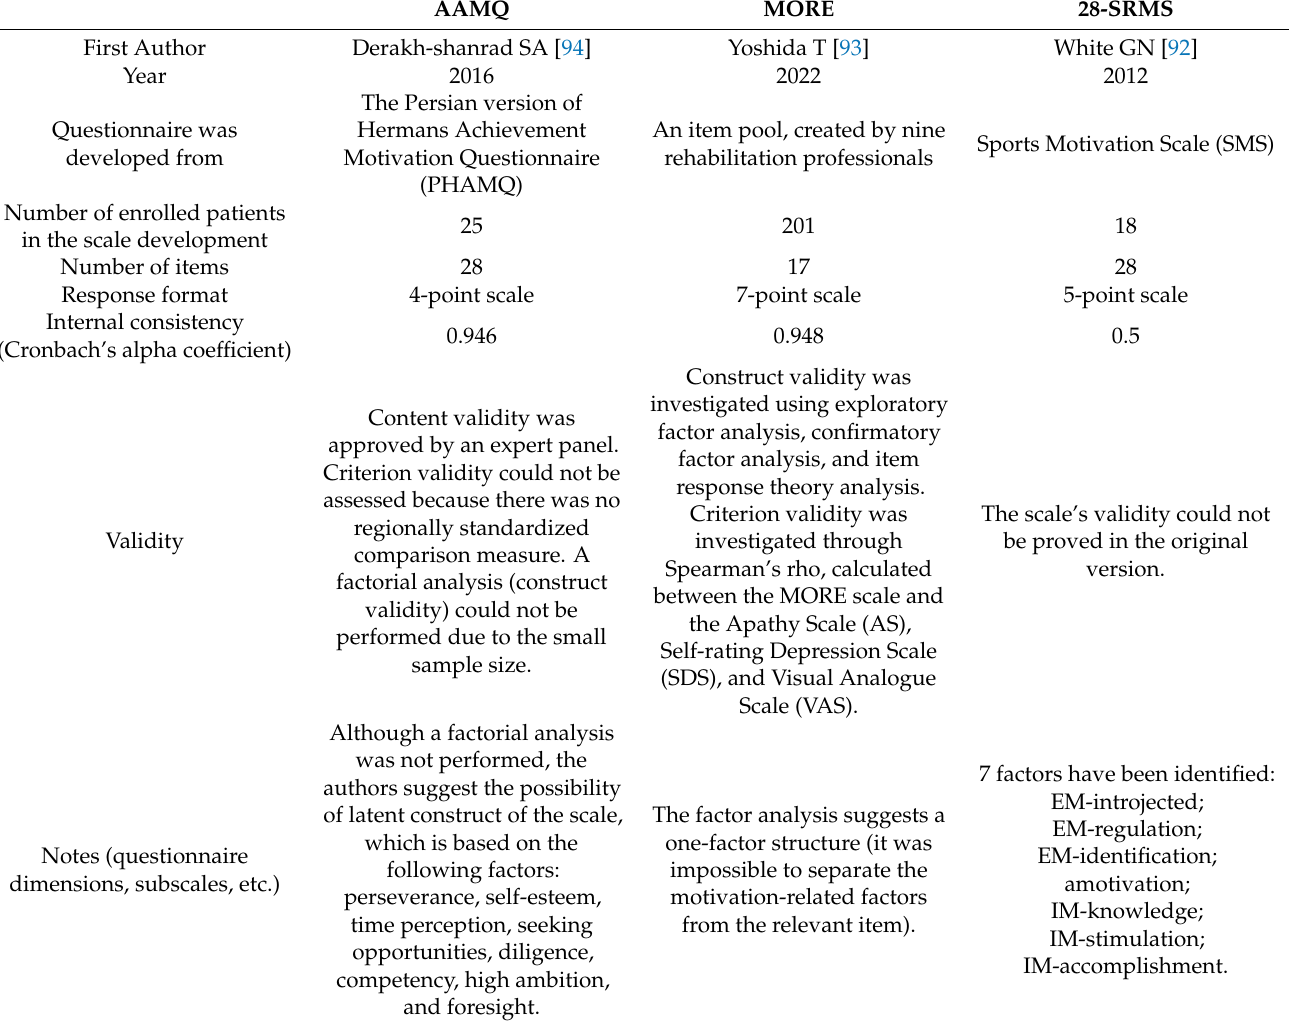
Table 3. Specifically designed for stroke patients in rehabilitation motivation